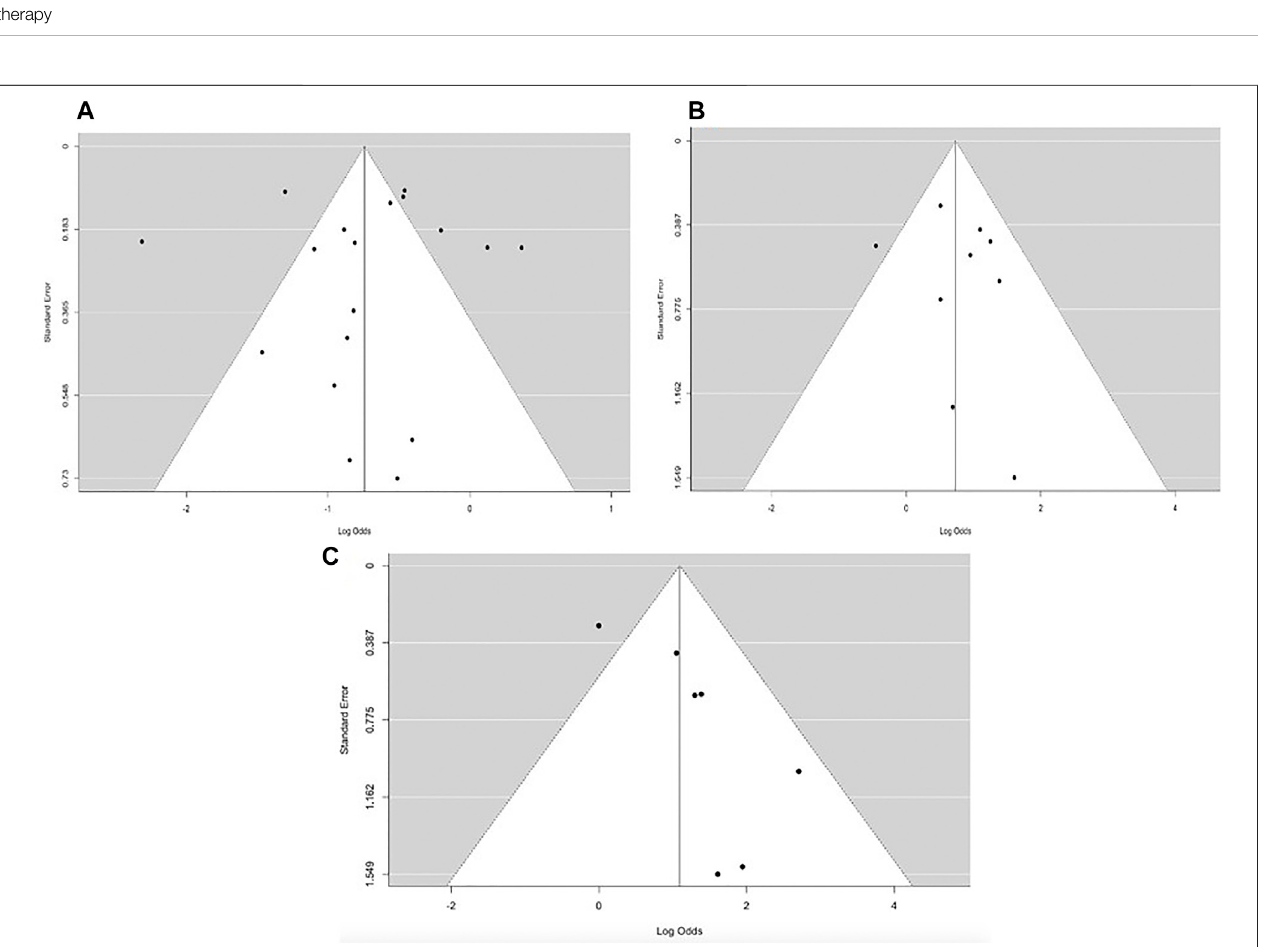
FIGURE 6 | Funnel plot for overall (A) mortality rate (B) clinical success and (C) microbiological response.